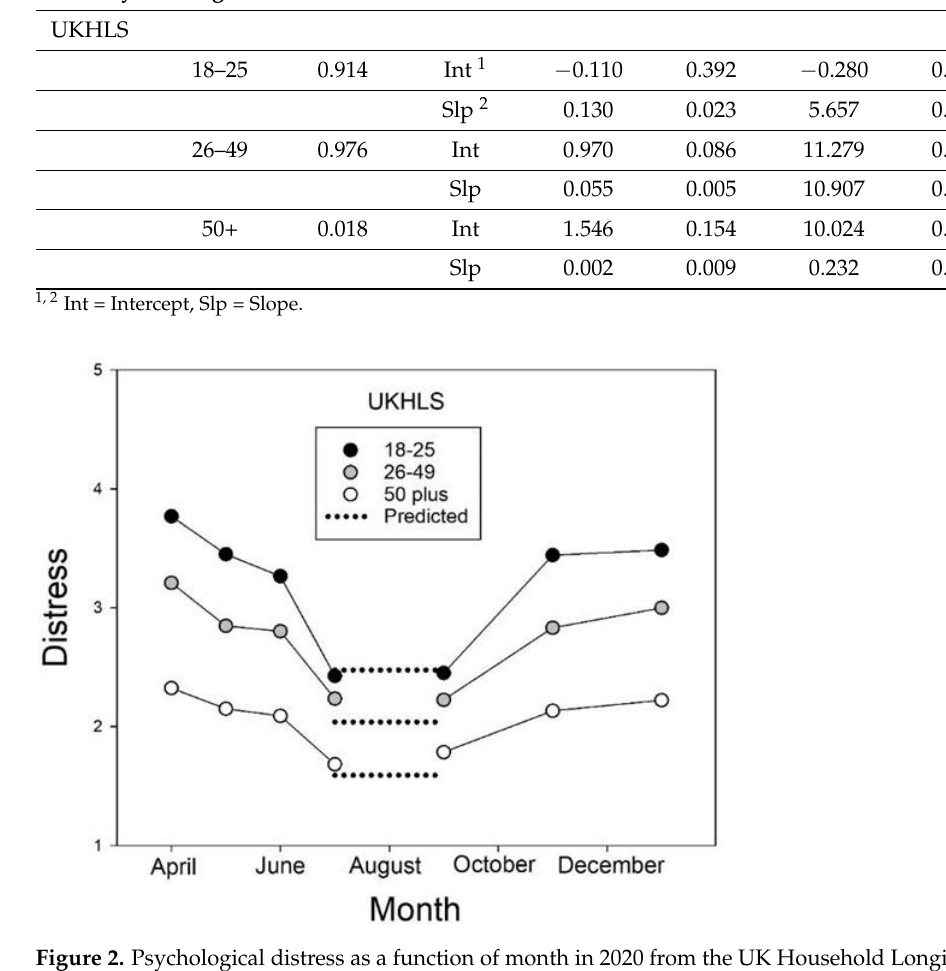
Figure 2. Psychological distress as a function of month in 2020 from the UK Household Longitudinal Study (UKHLS). Note that the first lockdown was in effect in April through June and the second lockdown began in November.